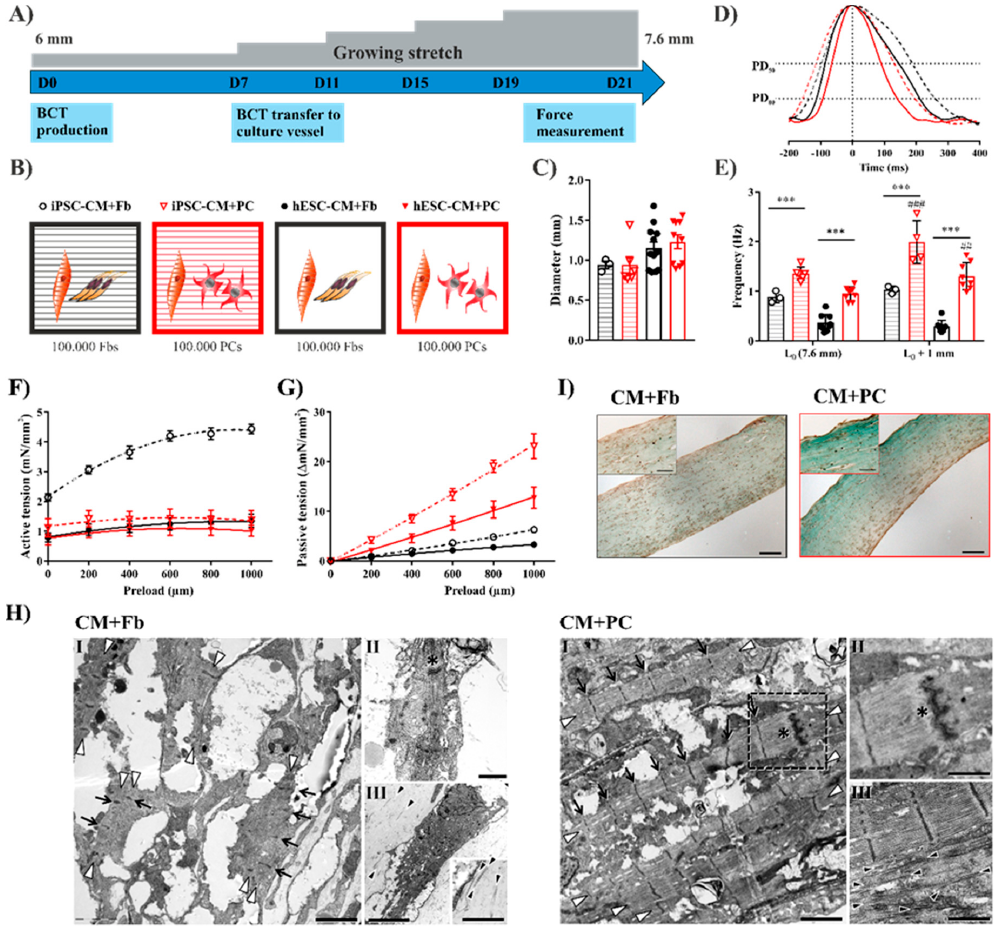
Figure 3. iPSC-PCs in cardiac tissues initiate a fibrosis-like remodeling process. ( A ) Schematic representation of BCT cultivation with growing stretch. ( B ) 1 × 10 6 iPSC- or hESC-derived CMs were mixed either with 1 × 10 5 hFFs or 1 × 10 5 iPSC-PCs for tissue formation. The colors and symbols serve as legends for the other diagrams of the illustration. ( C ) Tissue diameter measured on D21 (for C and E – G BCT with iPSC-CM n = 3–6; BCT with hESC-CM n = 9–12 tissues per group) ( D ) Representative spontaneous contractions normalized to peak height (iPSC-CMs—dashed lines, hESC-CMs. continuous lines). PD—peak duration at 50% and 80% peak height. ( E ) Frequency of spontaneous contraction before and after force measurement (*** p < 0.001 between indicated groups; ## p < 0.01 and ### p < 0.001 L 0 vs. L 0 + 1 mm). ( F ) Force of paced isometric contractions recorded over increasing preload measured on day 21. ( G ) Passive tension development with increasing preload. ( H ) Transmission Electron Microscopy of longitudinally sectioned BCTs. Left: hESC-CM+Fb; right: hESC-CM+PC. I: Myofibrils (white arrowheads) are visible in both tissues, however are more regularly distributed in CM+PC, with a higher width and constant Z-lines (arrows), while the fibrils in CM+Fb are narrow and the Z-lines appear out of phase. II: Cell–cell contacts (asterisks, right: enlargement from boxed area in I) are visible in both tissues. III: Collagen fibrils (black arrowheads) are dispersed in CM+Fb, while they are regularly arranged in CM+PC. Scale bars: I, 2 µm; II, 1 µm; III left, 5 µm/inset 1 µm; III right, 1 µm. ( I ) Masson’s trichrome staining of 7 µm paraffin sections of iPSC-CM BCTs with Fb (left) and iPSC-PC (right) image (scale bar: 100 µm). The post-rest potentiation (PRP), a measure of the capacity of the sarcoplasmic reticulum to store and release Ca 2+ , was less pronounced in hESC-CM+PC BCTs (Figure S5E). This effect on PRP was